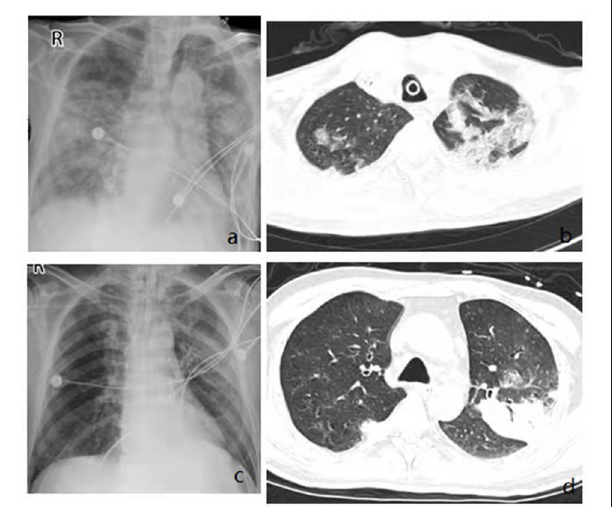
FIGURE 3 | Imaging findings showing diffuse multifocal or diffuse opacity. Chest x rays from admission showing bilateral diffuse infiltrates (a,c) , Chest CT from admission showing multifocal consolidation and groundglass opacity in both lungs (b,d) .